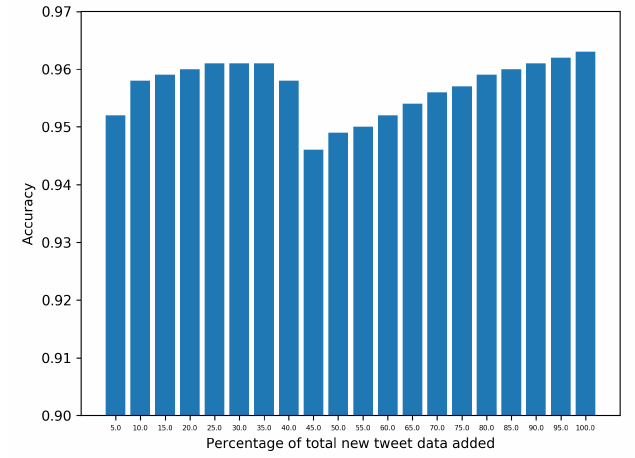
Figure 3. Accuracy of K − fold cross-validation (using Naive Bayes classifier) on augmented tweet data constituting labeled NLTK tweets and p = 5%,10%, . . . , COVID-19 tweets.